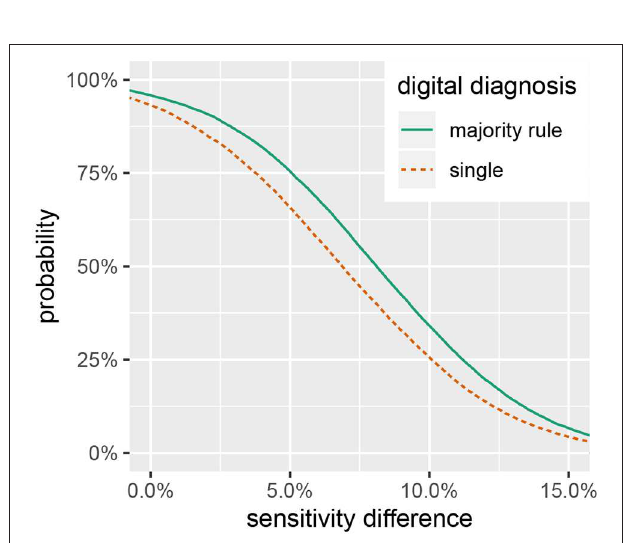
FIGURE 2 | Marginal posterior credible intervals for sensitivities and specificities. (Top) panels show results using majority-rule digital diagnoses ( Table 3 ), and (Bottom) panels show results of using only one digital diagnosis per colony ( Table 2 ). Points indicate posterior medians, inner credible intervals are at the 50% level, and outer intervals at 90%